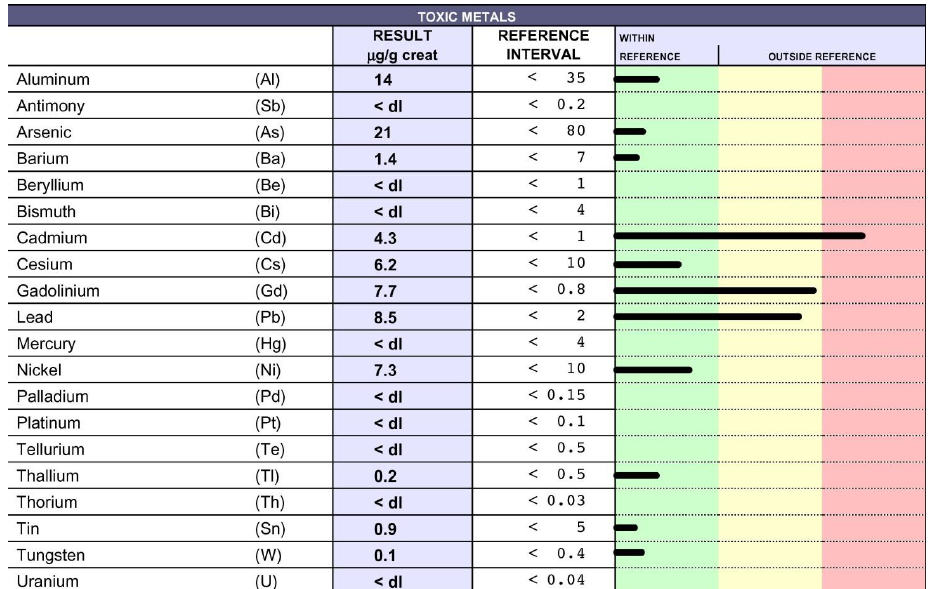
Figure 3. Detection of TMs in the urine samples of IM: IM gave consent to the chelation therapy; thus, the presence of TMs was detected in her urine samples following challenge with EDTA,